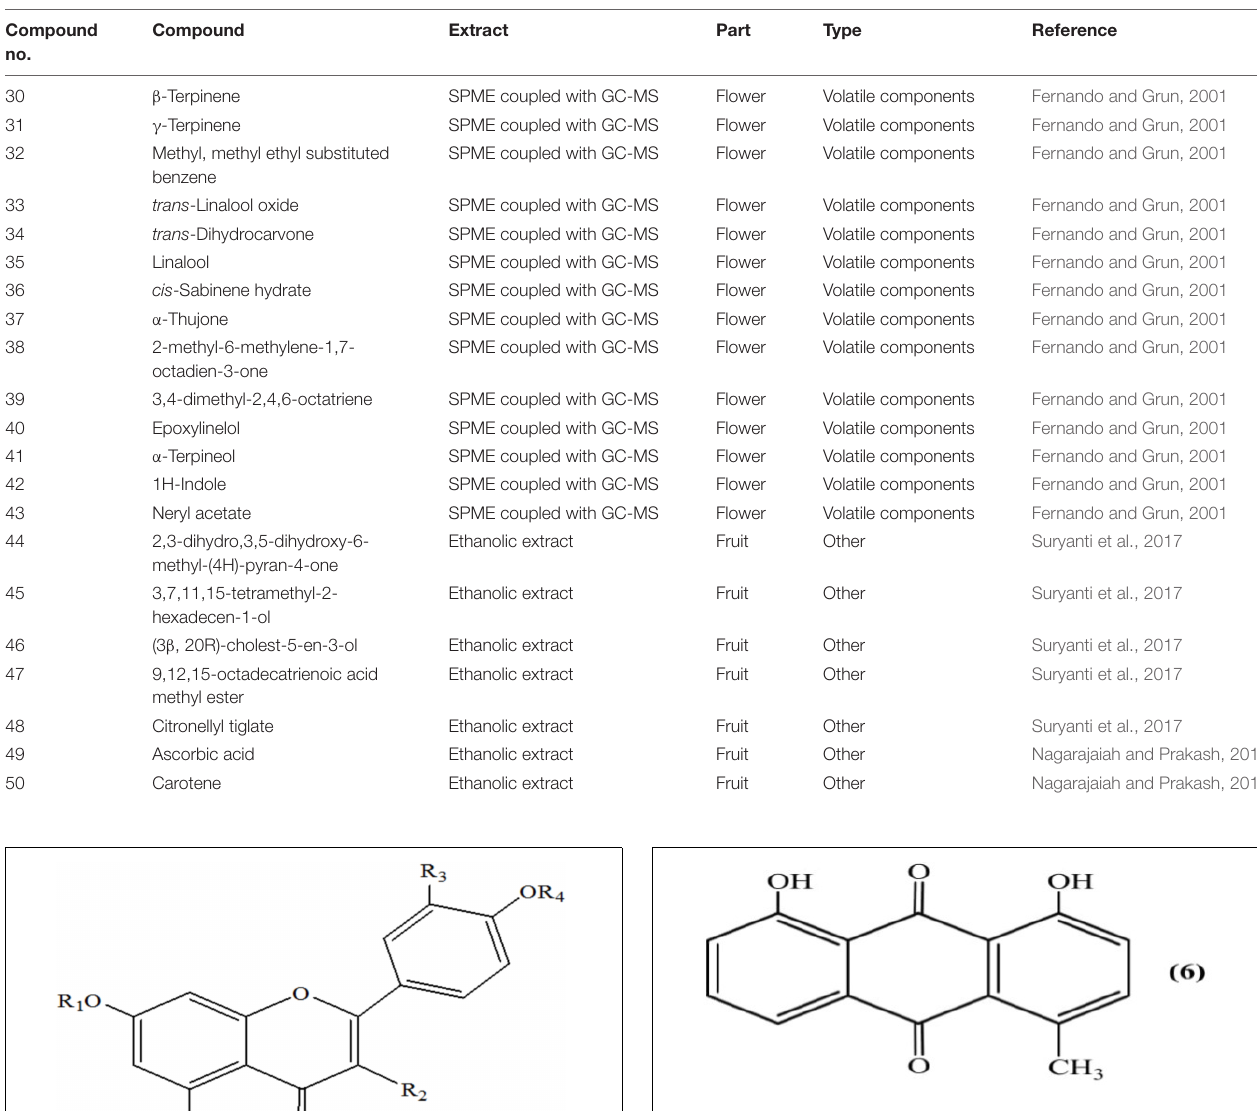
Nutritional evaluation of seed showed the presence of fats, proteins, and minerals. The protein and fat obtained from the kernel were 39% and 44% of the total weight, respectively.